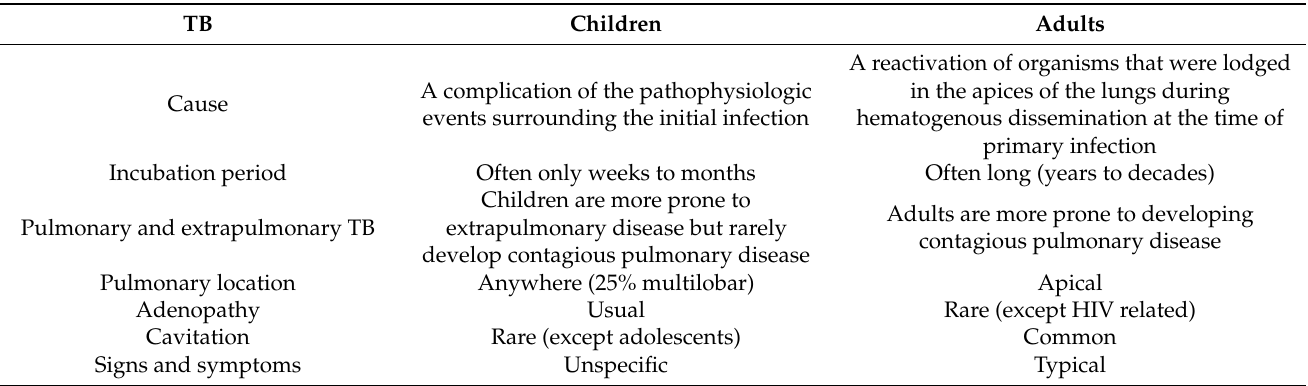
Table 1. Clinical differences in children vs.